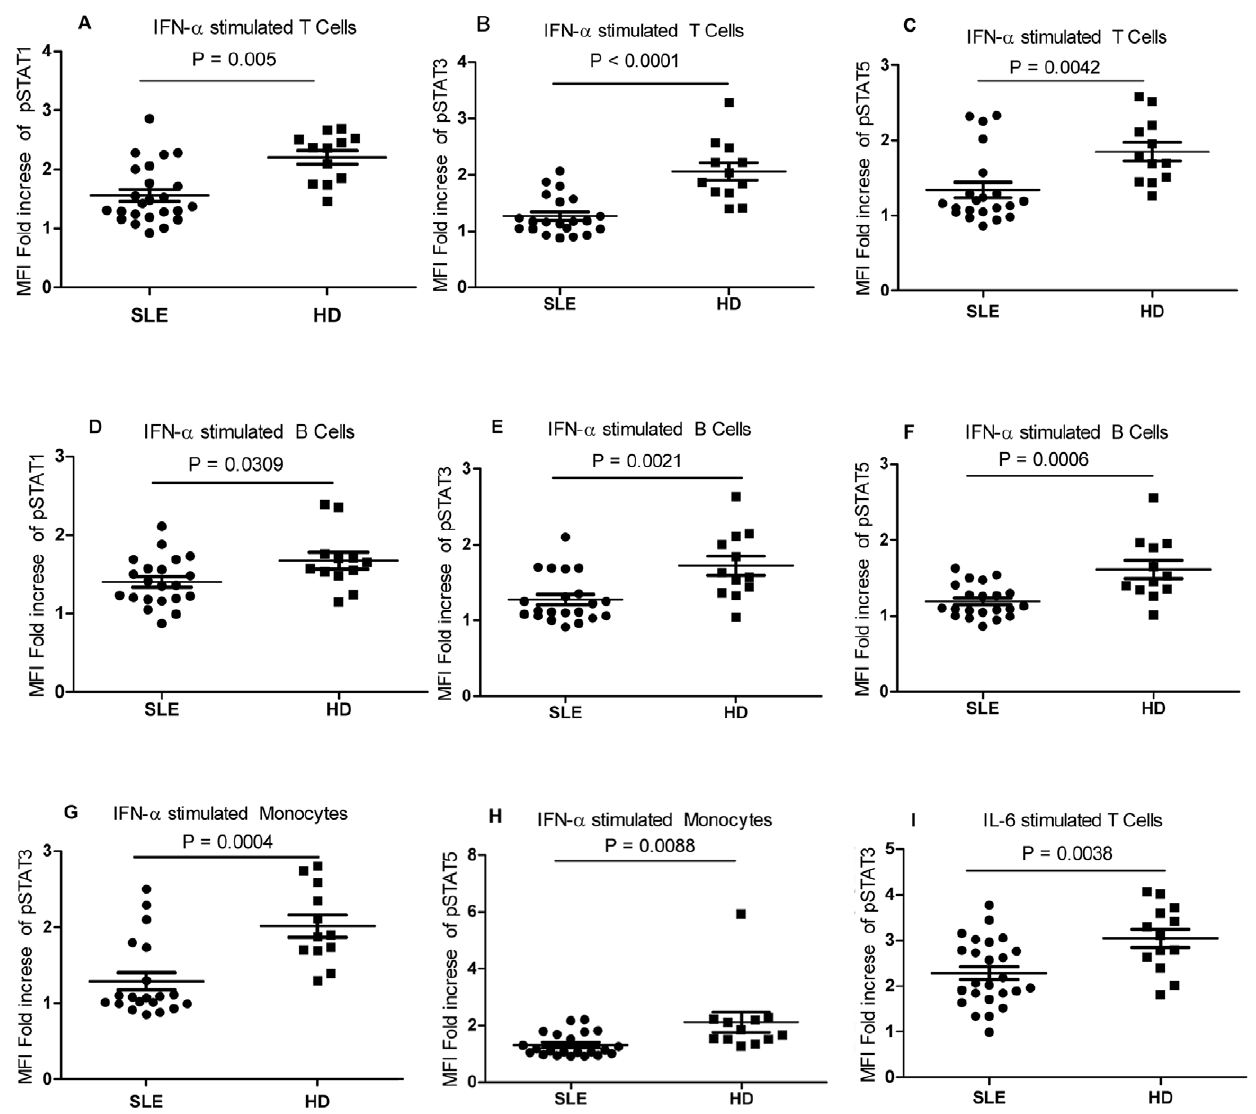
Figure 7. pSTATs in SLE patients after cytokine stimulation. The MFI for the phosphorylation of STAT1 (5A), STAT3 (5B), and STAT5 (5C) in the T cells of SLE patients decreased significantly after IFN a stimulation for 15 min. The MFI for the phosphorylation of STAT1 (5D), STAT3 (5E), and STAT5 (5F) decreased in the B cells of SLE patients after IFN a stimulation for 15 min. The MFI for the phosphorylation of STAT1 (5G) and STAT3 (5H) in the monocytes of SLE patients decreased after IFN a stimulation for 15 min. The MFI for pSTAT3 (5I) decreased significantly in the T cells of SLE patients after IL6 stimulation for 15 min. MFI, mean fluorescence index; SLE, systemic lupus erythematosus; HD, healthy donors; IFN a , interferon a .